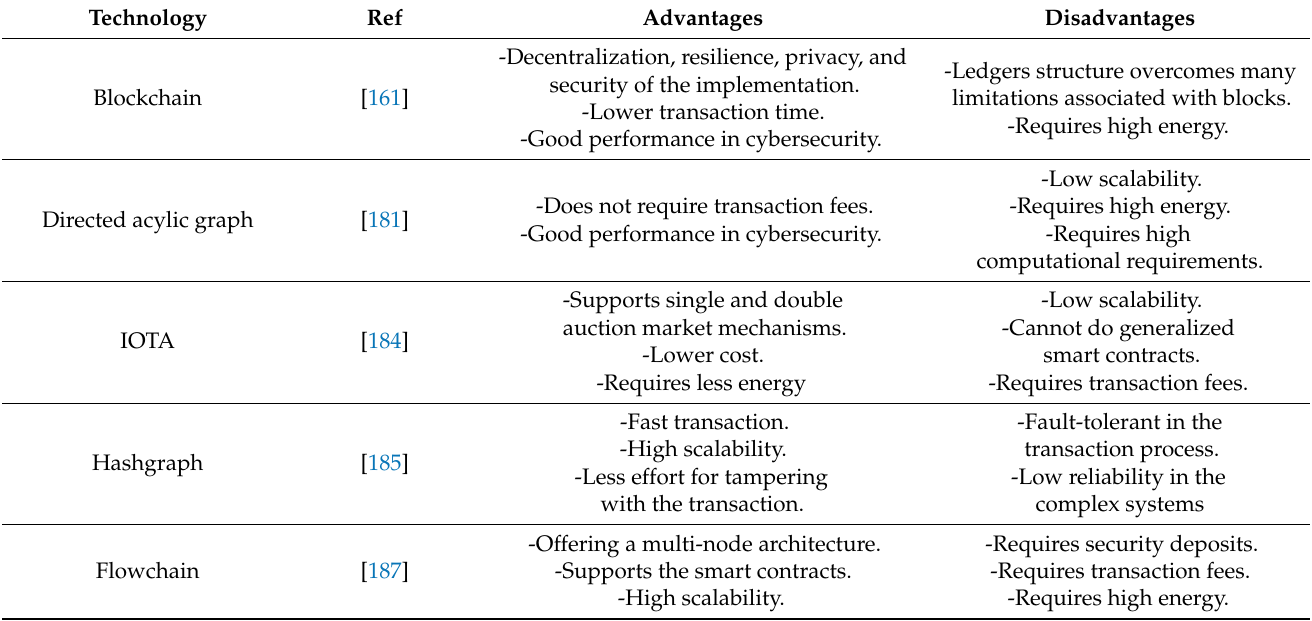
Table 7. Summary of the advantages and disadvantages of different distributed ledger